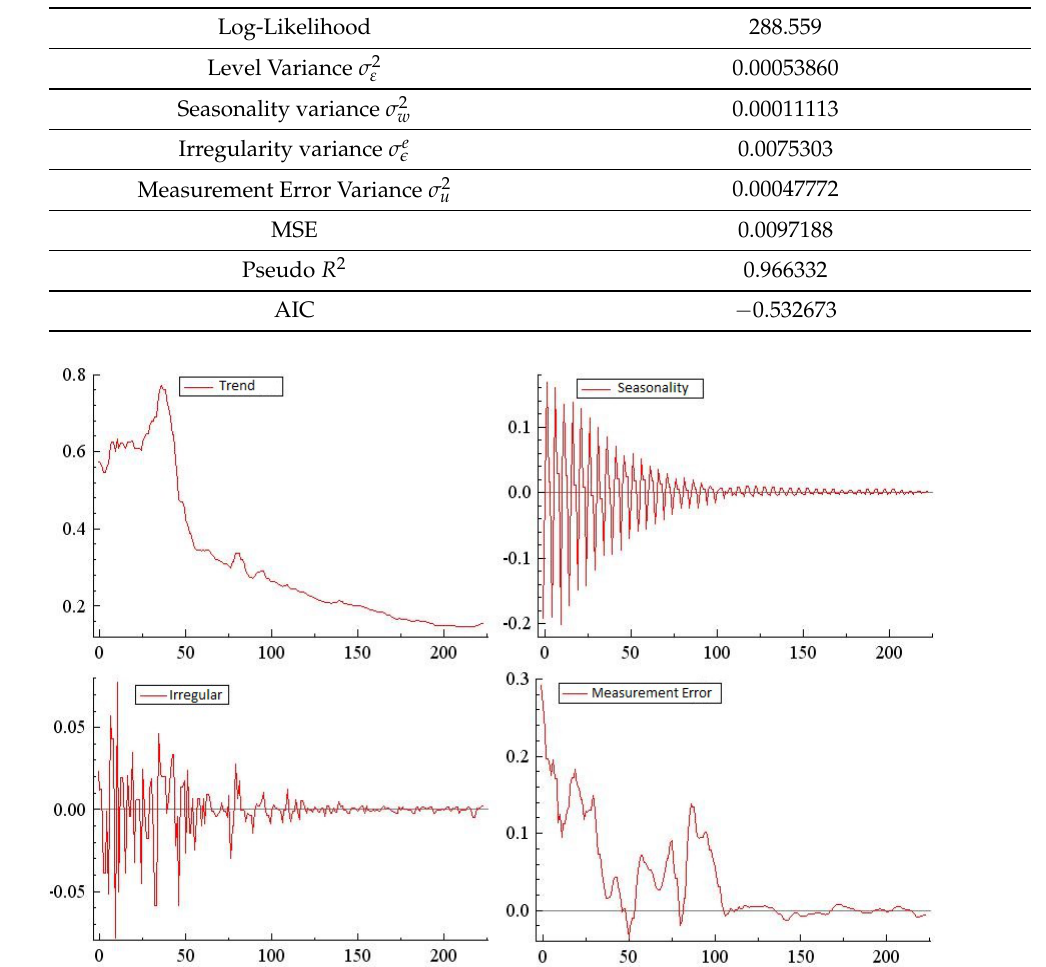
Figure 2. Estimations of the components of the